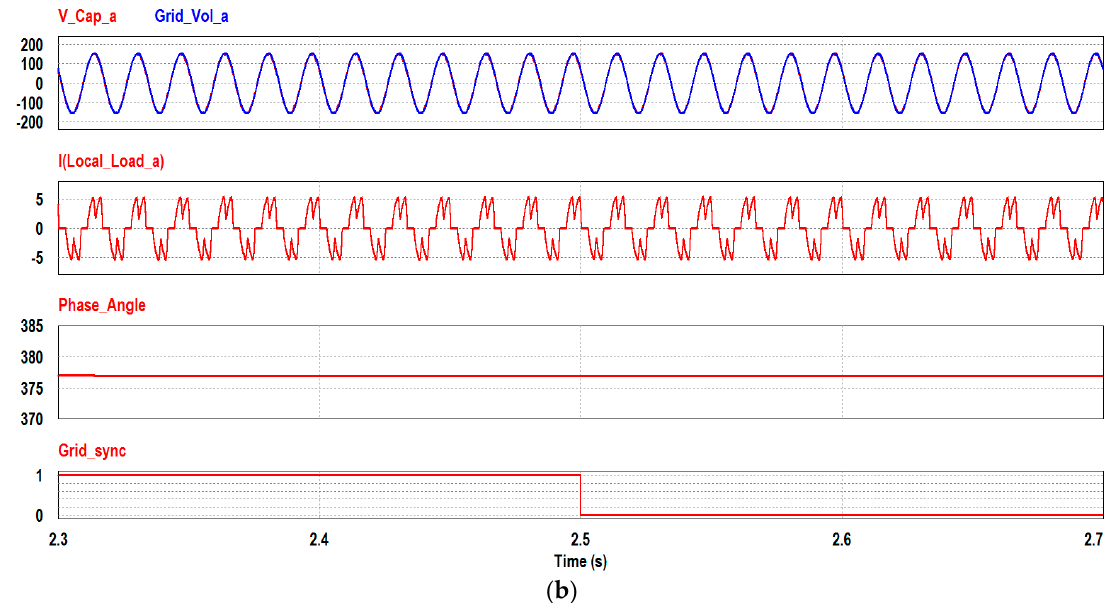
Figure 15. Simulation results when mode changes from GS to SBGC in Case IV: ( a ) Grid synchronization, ( b ) mode change from GS to SBGC. (From top to bottom: Measured a -phase inverter output voltage and grid voltage, a -phase local load current, instantaneous angular frequency of output voltage, and GS status signal).